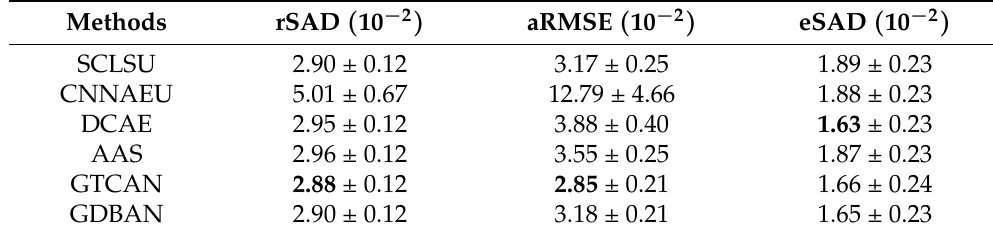
Table 2. Quantitative results on synthetic data (SNR = 30 dB). The optimal results are bolded. Methods